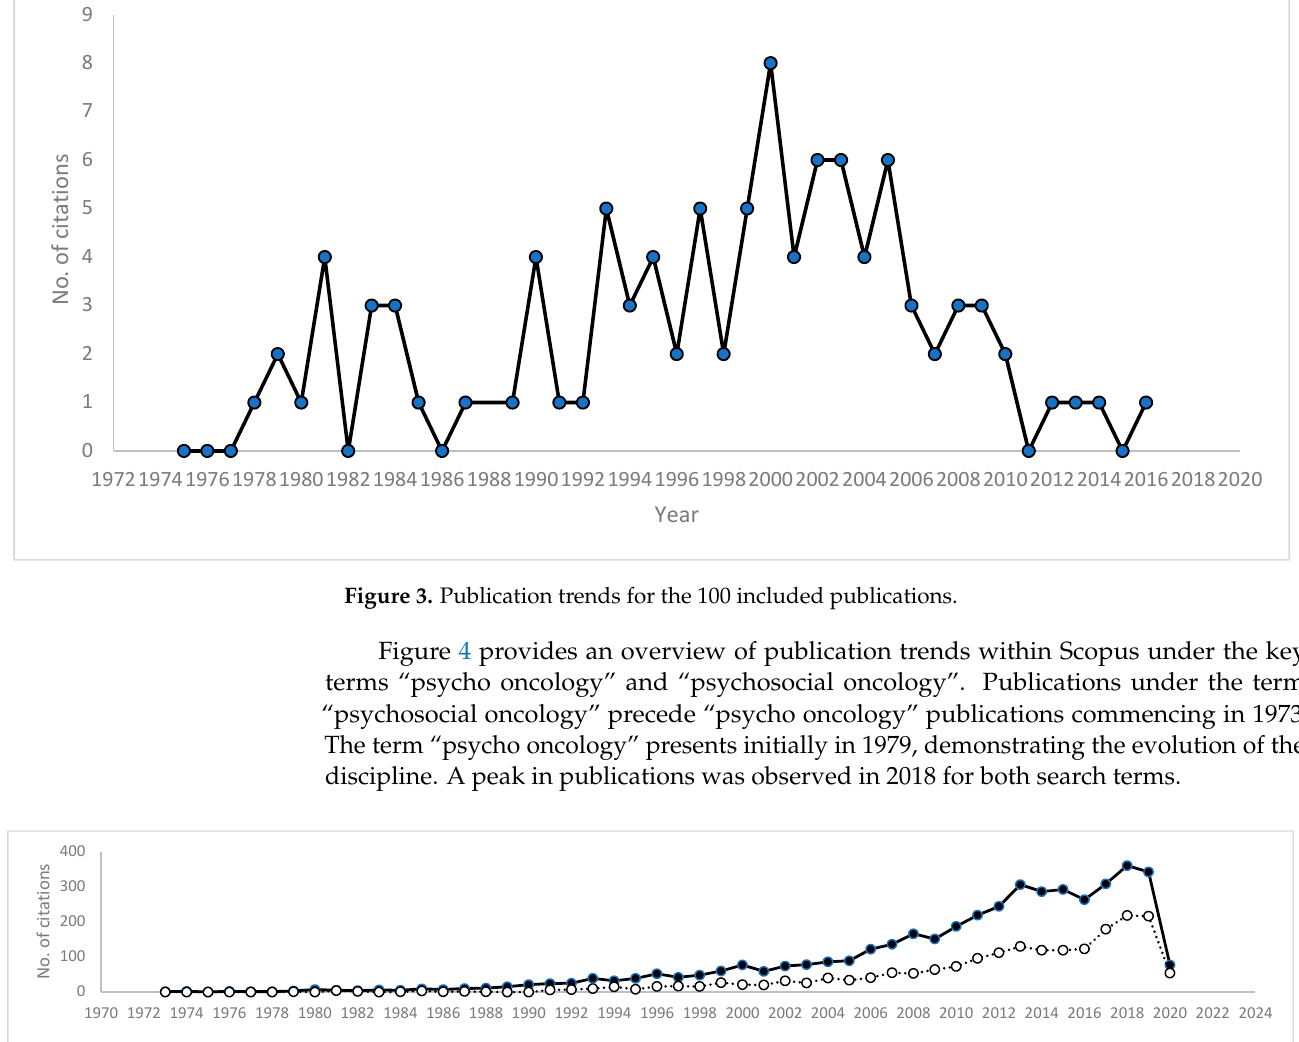
Figure 4. Publications by year for the terms “psychosocial oncology” and “psycho-oncology” in